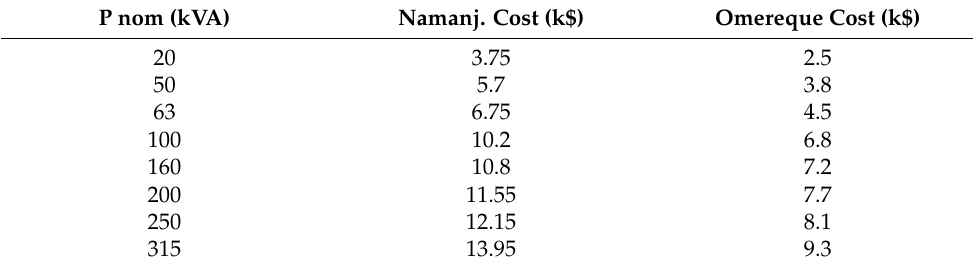
Table 4. Transformers’ costs.